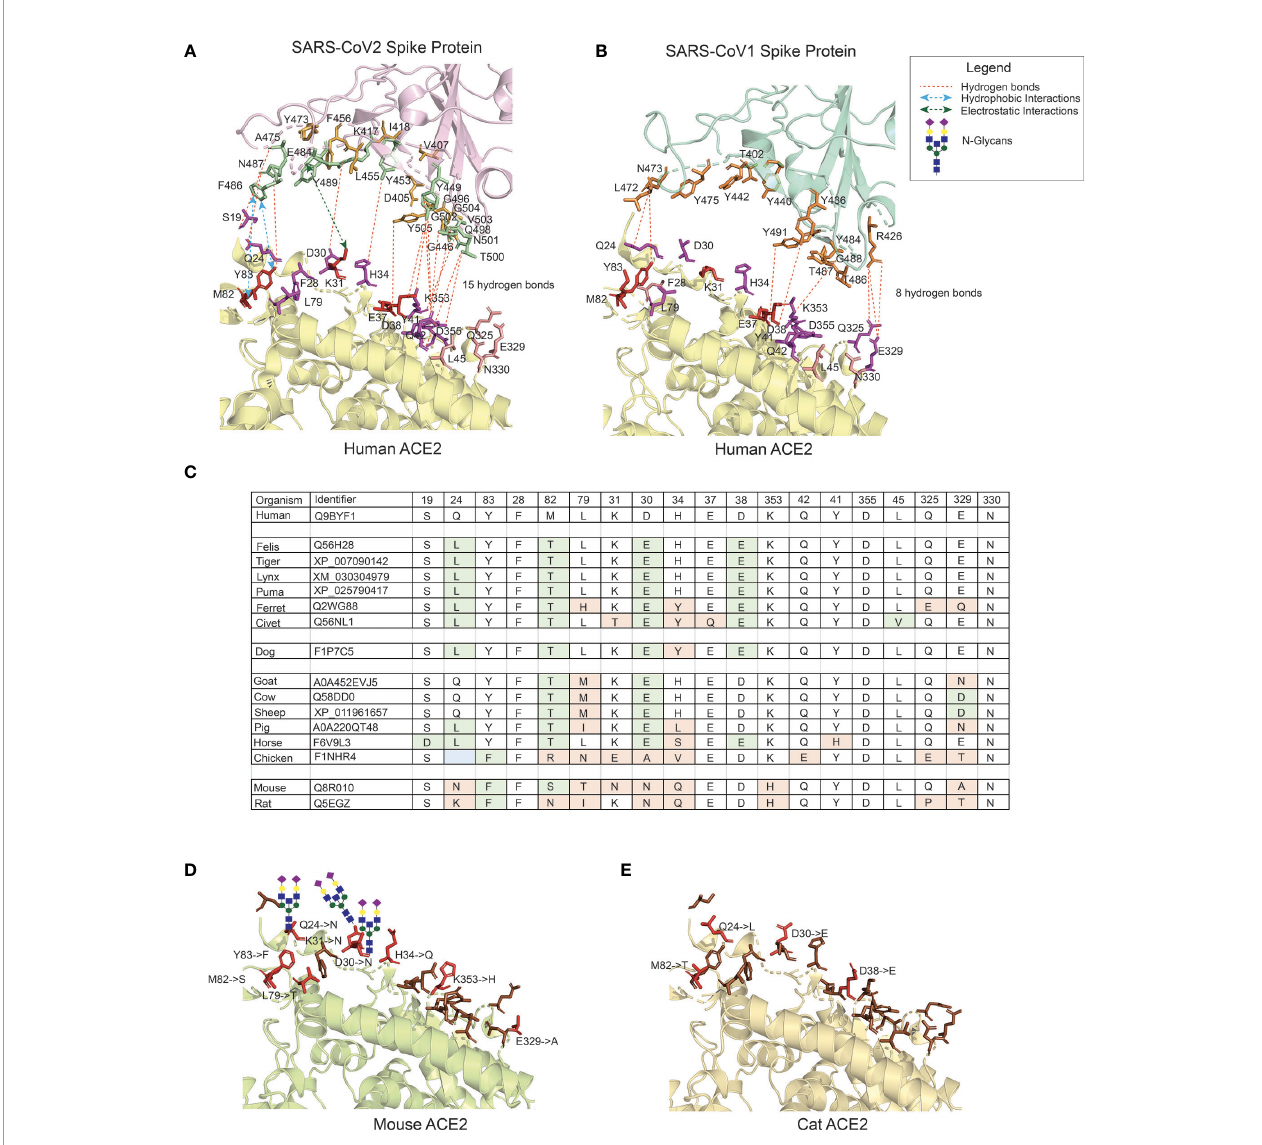
FIGURE 1 | The interface of ACE2 protein in different organisms with important amino-acid residues for interacting with the Spike (S) protein of SARS-CoV viruses. (A) The interacting interface between h ACE2 protein and CoV2 S (PDB ID: 6LZG). The residues in h ACE2 proteins are colored in red, magenta and pink. Red residues are the most important and pink the least. The interacting residues in CoV2 S are colored in green and orange colors where green residues are the important interacting residues. The distance between CoV2 Spike and h ACE2 proteins is increased to better visualize the residues and the interactions. (B) The interacting interface between h ACE2 protein and CoV1 S (PDB ID: 2AJF). Red residues on h ACE2 protein are important residues for maintaining the interaction between h ACE2 and CoV1 S proteins. All the residues in CoV1 S interacting with h ACE2 are colored in orange. The distance between CoV1 Spike and h ACE2 proteins is increased to better visualize the residues and the interactions. Hydrogen bonds (1A and 1B) as described in the structures of these interaction (PDB ID: 6LZG and 2AJF) and electrostatic and hydrophobic bonds in CoV1 S- h ACE2 interaction are depicted from Brielle et al. (4). (C) The positions mutated in ACE2 proteins in selected vertebrates that are either pets, domesticated or live in vicinity of humans. The mutated residues are shaded with green or orange background. The green background represents mutations resulting in similar property residue i.e. polar -> polar or non-polar -> non-polar. The orange background represents mutations resulting in changes in the residue property i.e. polar -> non-polar. (D) The interface of mouse ’ s ACE2 protein. Red color residues represent the mutated residues. Three mutations on the left interacting region has resulted in an Arginine, introducing a glycan site. The basic structure of glycan is shown on the sites. (E) The interface of cat ’ s ACE2 protein. The red color residues represent the mutated residues. The mouse ’ s and cat ’ s ACE2 structure are modelled with modeller-9.24 (65) using 6LZG as a